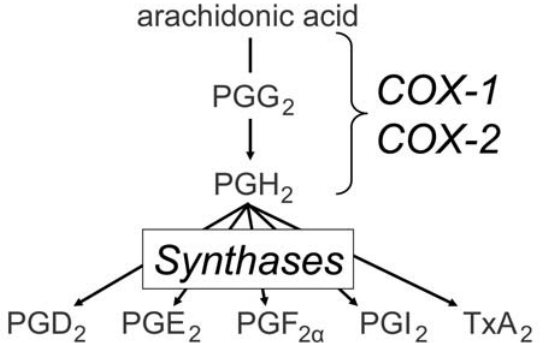
FIGURE 2. The cyclooxygenase pathway. The enzymes COX-1 and COX-2 initiate the synthesis of prostanoids from AA, producing PGH 2 in a two-step process. The generation of end-products from PGH 2 is mediated by specific synthases that are distributed in a cell-specific